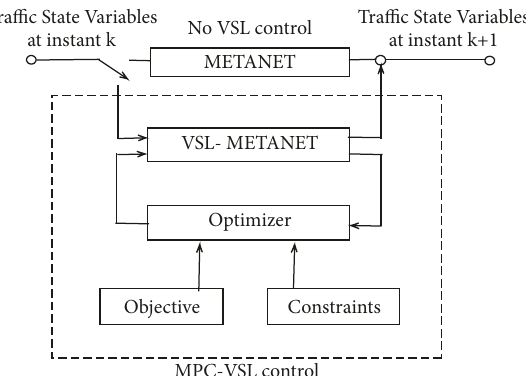
Figure 1: The block diagram of model predictive VSL control.